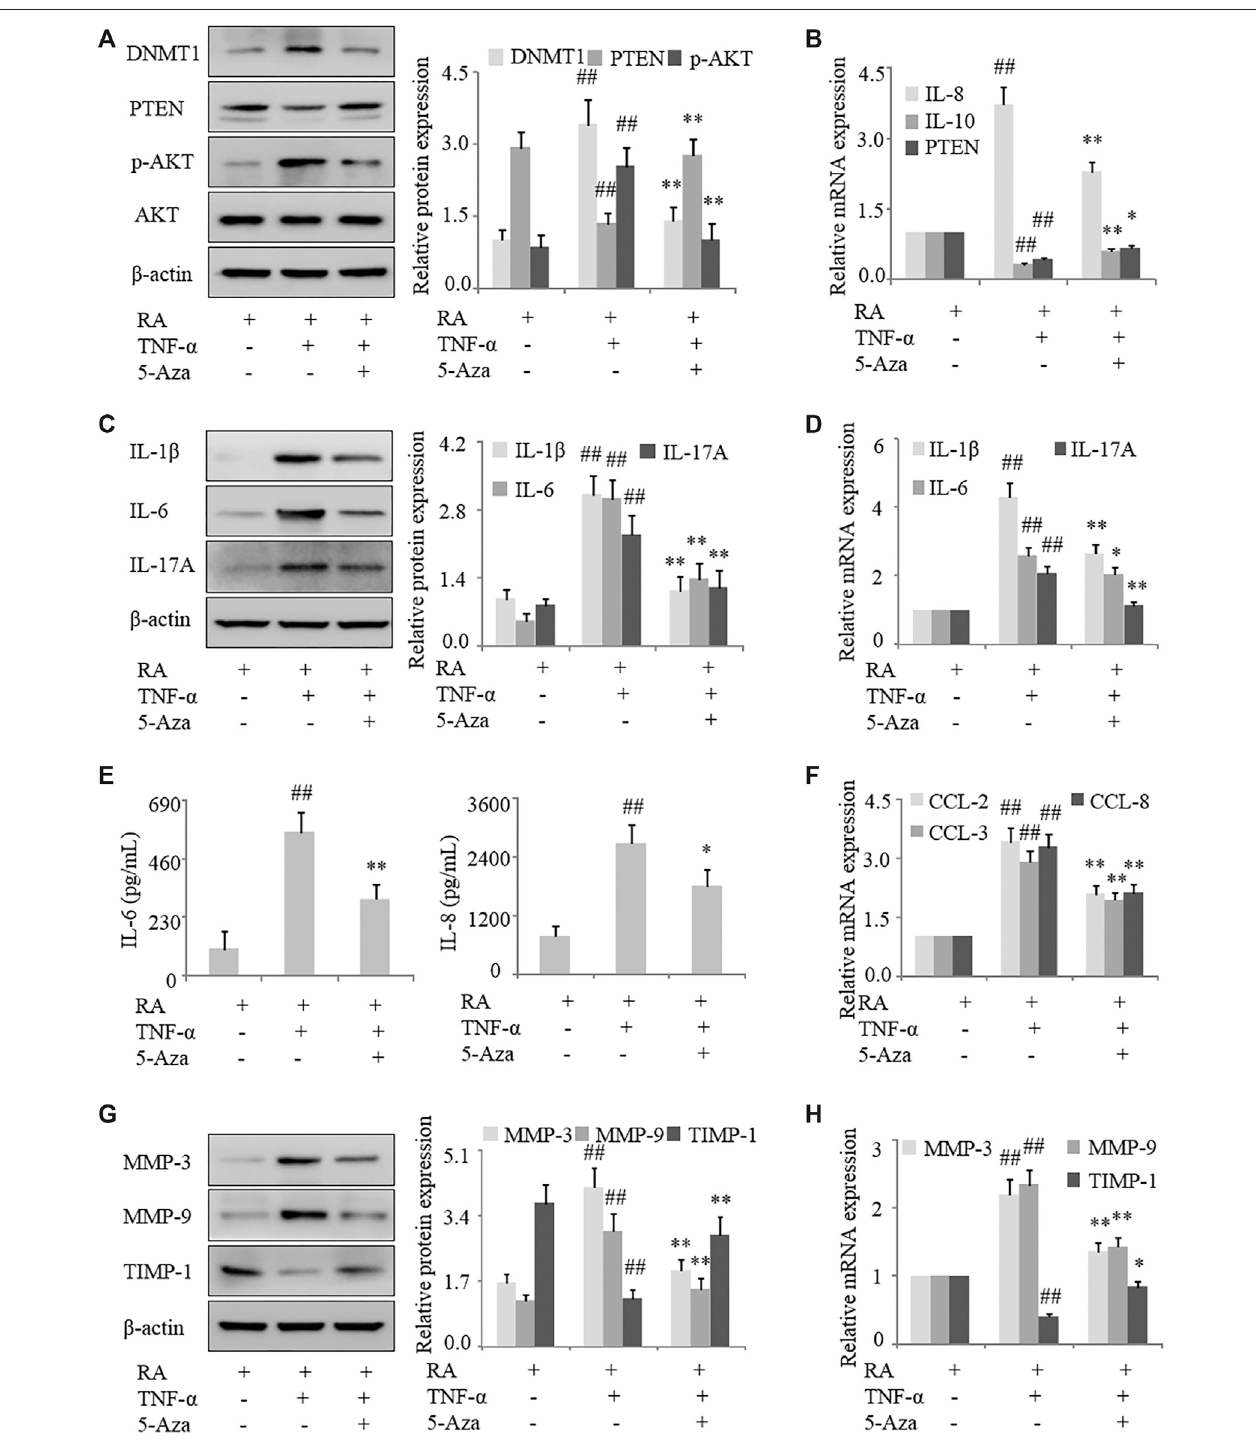
FIGURE3| InhibitionofDNAmethylationsuppressesin fl ammationandFLSactivationinRA.FLSfromRApatientsweretreatedwithTNF- α (10 ng/ml)and5-azadC(2 μ M). (A) DNMT1,PTEN,and p -AKTproteinlevelsdetectedbywesternblotting. (B) PTEN , IL-10 ,and IL-8 mRNAlevelsdetectedbyqRT-PCR. (C,D) IL-1 β ,IL-6,andIL-17AmRNAand proteinlevelsanalyzedbyqRT-PCRandwesternblotting,respectively. (E) IL-6andIL-8intheculturesupernatantdetectedbyELISA. (F) CCL-2 , CCL-3 ,and CCL-8 mRNAlevels detectedbyqRT-PCR. (G,H) MMP-3,MMP-9,andTIMP-1mRNAandproteinlevelsanalyzedbyqRT-PCRandwesternblotting,respectively.Valuesrepresentmean ± SD. ## p < 0.01 vs. AIA or RA group; * p < 0.05, ** p < 0.01 vs. TNF- α group.